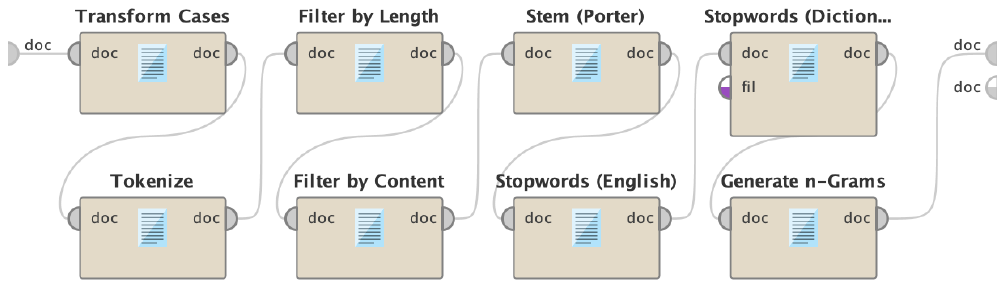
Figure 5. Subprocesses of the Process Document from Data operator. The inputs of the processes were the collected tweets that had undergone the data annotation phase, and the outputs were the word vectors.